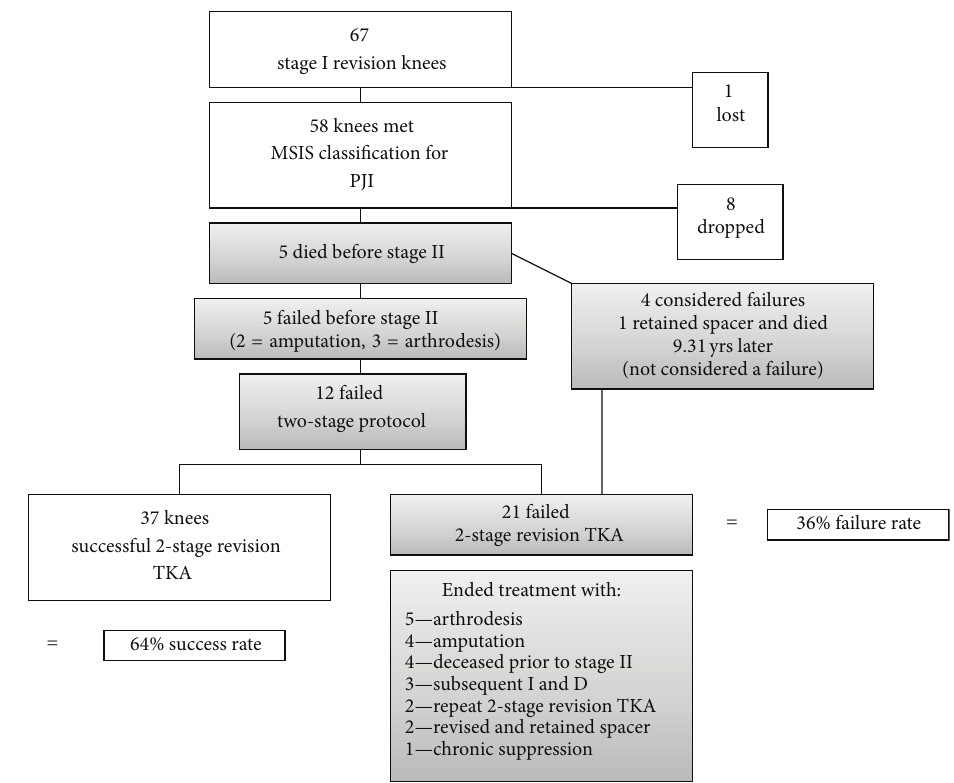
Figure 1: Flow diagram demonstrating the inclusion and exclusion of participants in the